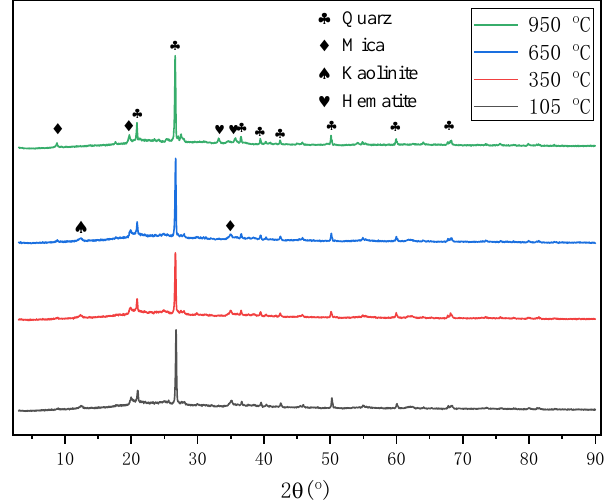
Figure 1. XRD images of ceramsite at different temperatures (from the bottom to the top, the temperature goes up).